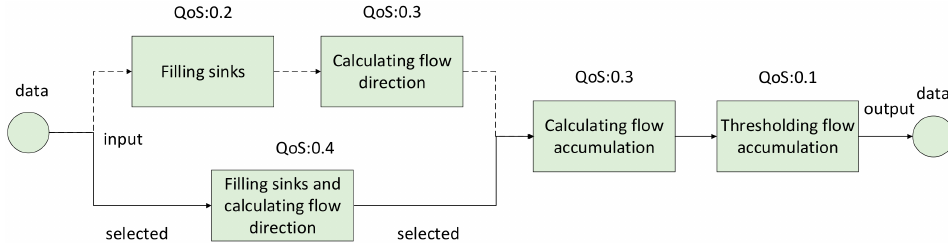
Figure 7. River network